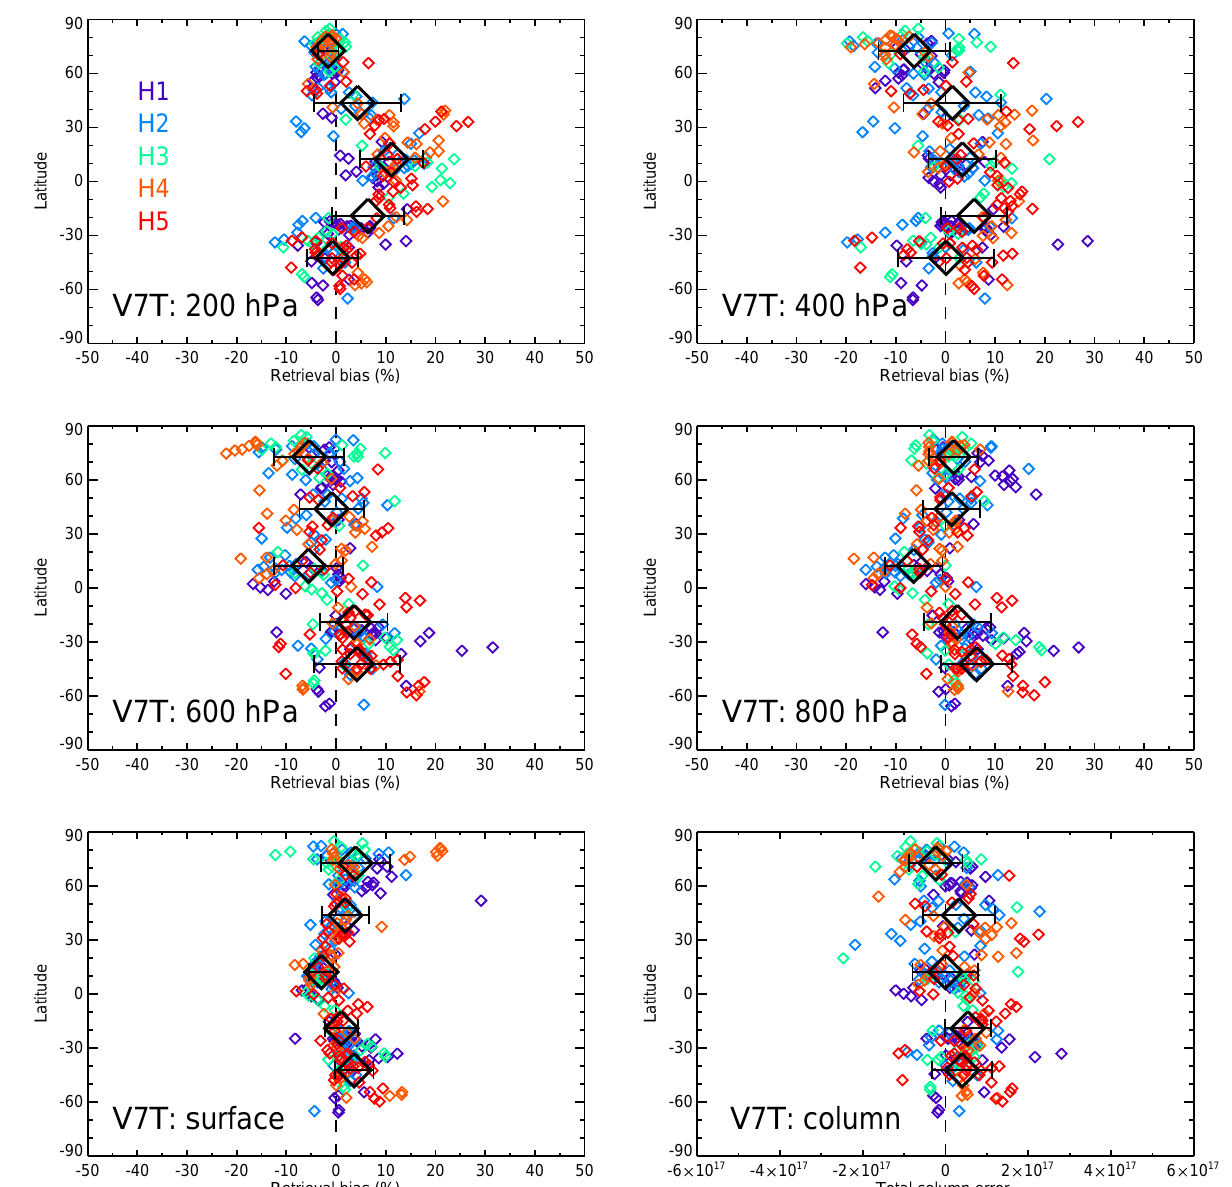
Figure 18. Latitude dependence of V7 TIR-only biases based on the HIPPO CO profiles. See caption to Fig. 17.